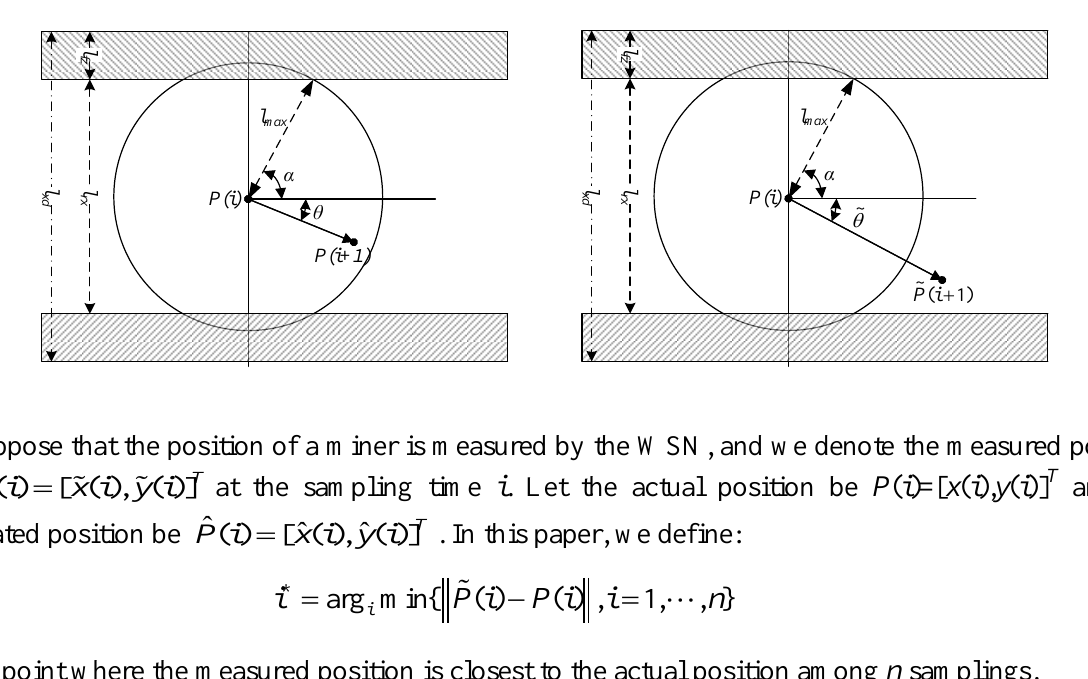
Figure 6. The personnel moving angle and range limitation in a